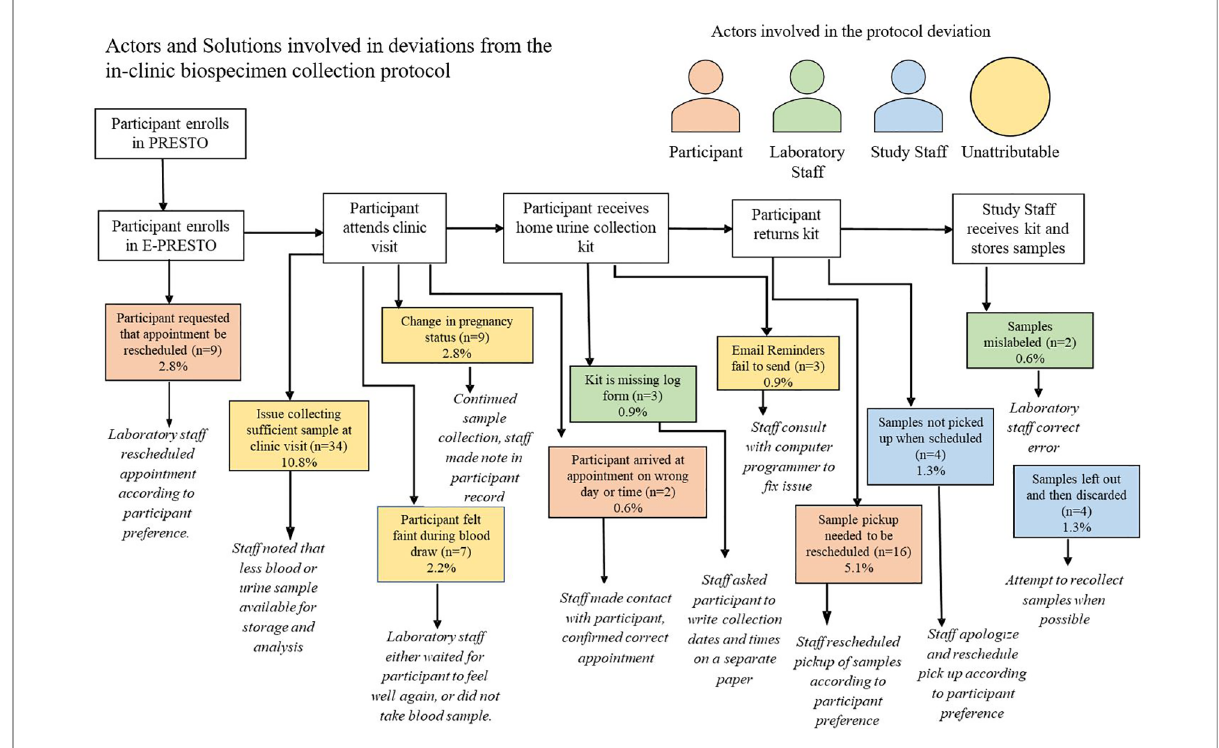
FIGURE 4 Actors and solutions involved in deviations from the in-clinic biospecimen collection